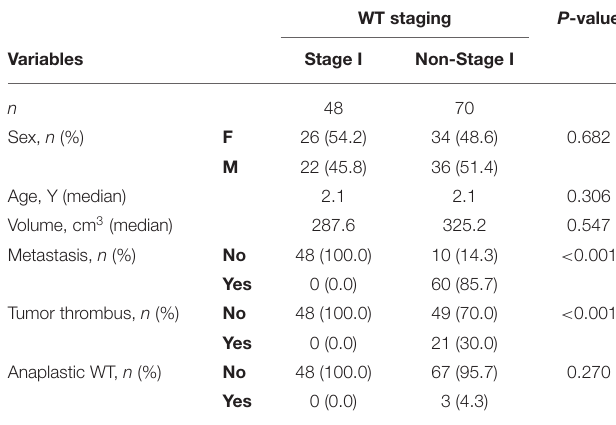
TABLE 1 | Demographic data and clinical factors of WT